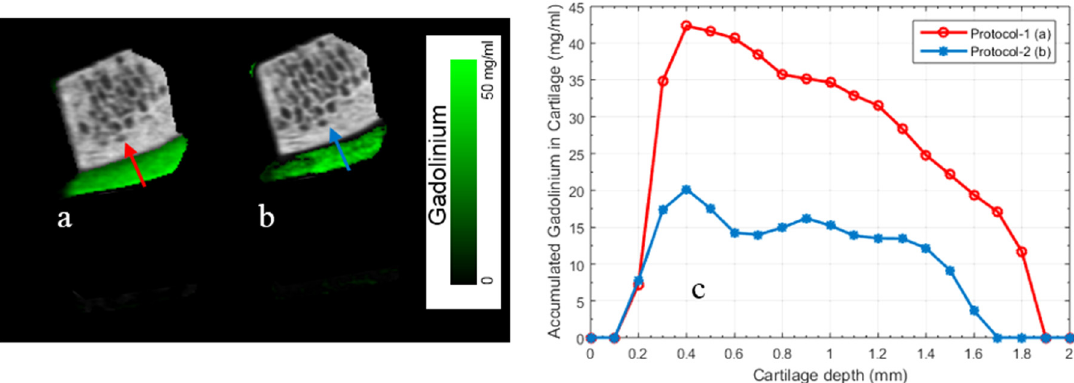
Figure 14. Fused images of bovine knee specimens with protocol-1 ( a ) and protocol-2 ( b ) with a gadolinium channel displayed quantitatively using a green color map with concentration ranging from 0 to 50 mg Gd/mL; ( c ) shows a quantified correlation in gadolinium uptake between the two protocols with respect to cartilage thickness (corresponding to arrow directions in ( a , b ). It is evident that despite using the same biological specimen, the two imaging protocols are reporting different